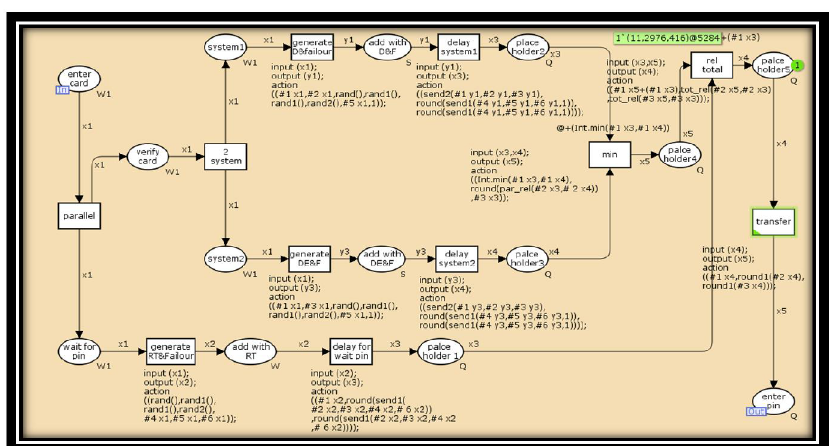
Fig. 7. The high-level model of ATM